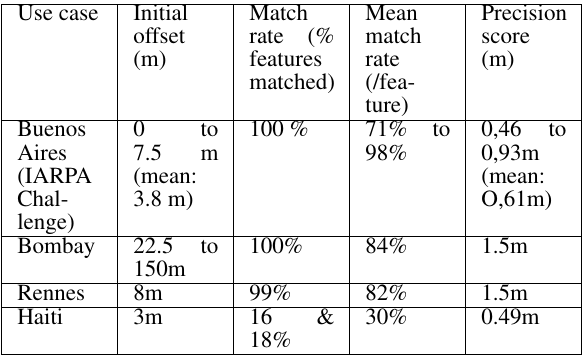
Table 4. Results of the registration method on VHR images